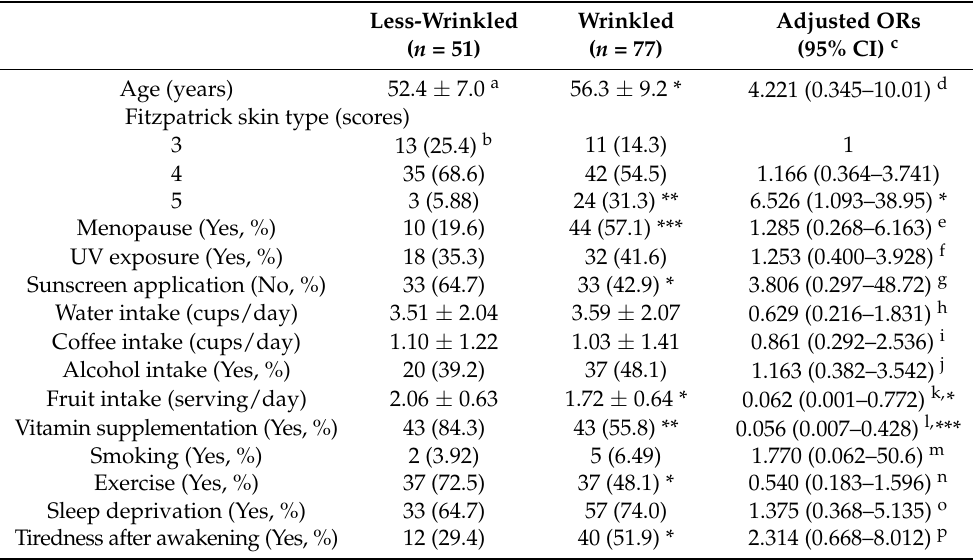
Table 2. Adjusted means and odds ratio (ORs) of demographic characteristics of the participants according to facial wrinkles.